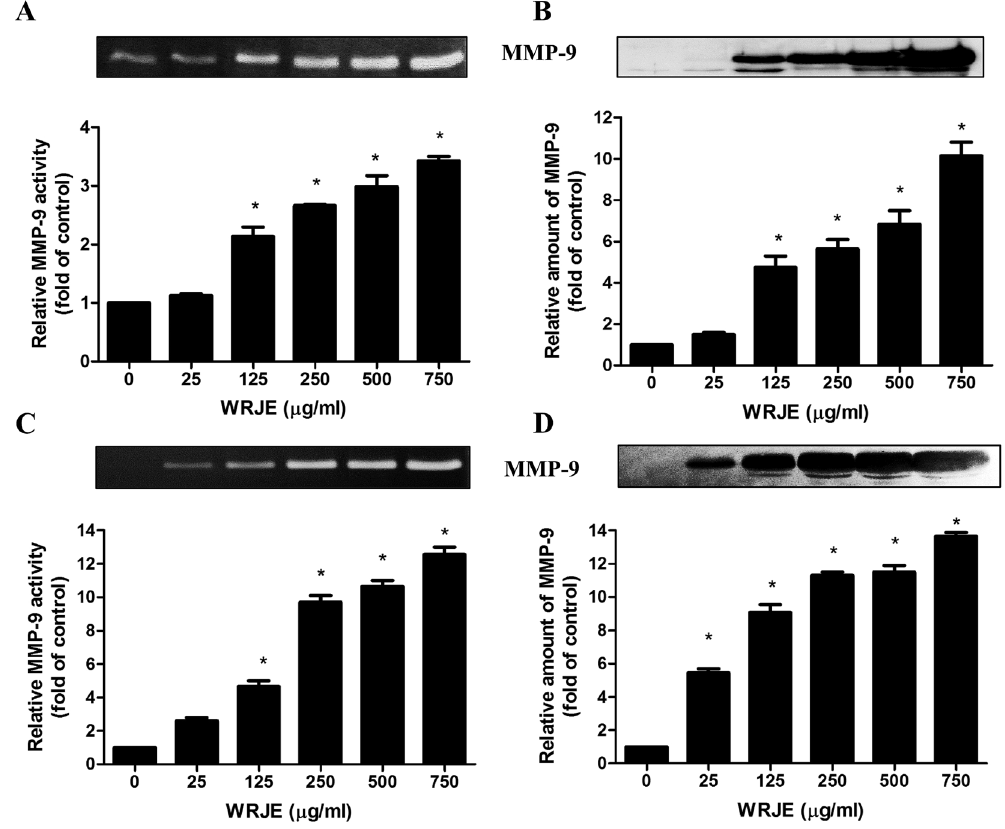
Figure 1. The effect of a water royal jelly extract (WRJE) on matrix metalloproteinase 9 (MMP-9) secretion and proteolytic activity in HaCaT cells ( A , B ) and human epidermal keratinocytes (HEK) ( C , D ). HaCaT and HEK cells were treated with different doses of WRJE for 72 h. ( A , C ) Conditioned equal volumes of the culture media were collected and subjected to gelatine zymography. Densitometric quantification of MMP-9 activity in culture media is presented. ( B , D ) Conditioned equal volumes of the concentrated culture media were subjected to 10% SDS-PAGE gels. MMP-9 (92 kDa) was detected by Western blotting and quantified densitometrically. The gels were run under the same experimental conditions. Shown are cropped gels/blots. (The gels/blots with indicated cropping lines are shown in Supplementary Fig. S2). Data are expressed as means and SEMs of three independent measurements. Asterisks indicate a significant difference from the untreated group, * P <